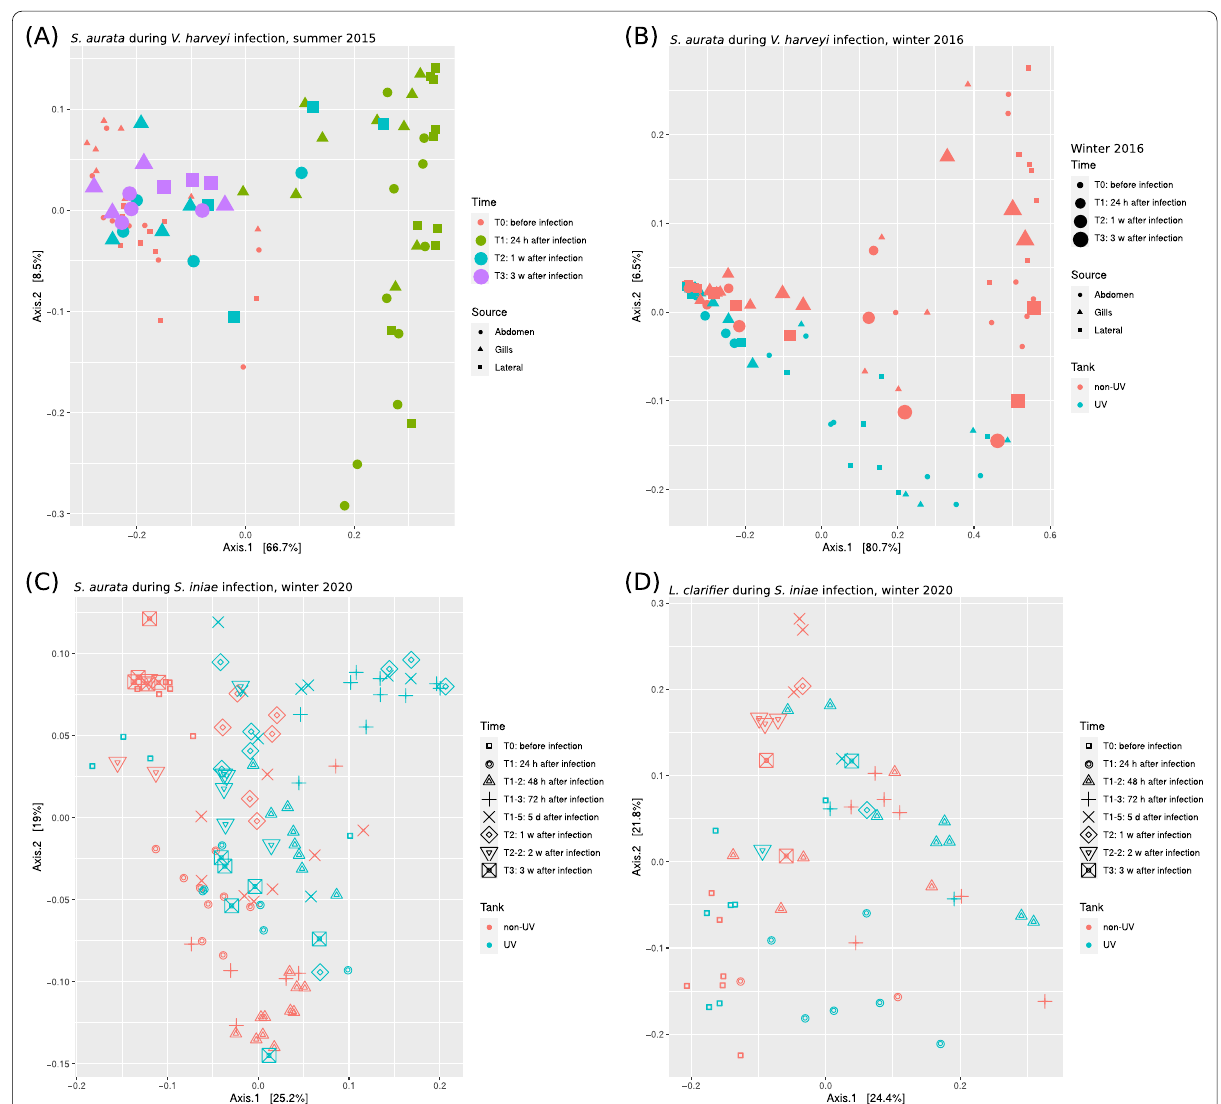
Fig. 3 PCoA ordination plots based on weighted Unifrac distance matrix for different experiments. PCoA plots for S. aurata during V. harveyi infection, summer 2015 season ( A ) and winter 2016 season ( B ). C and D Shows PCoA plots during S. iniae infection for S. aurata ( C ) and L.